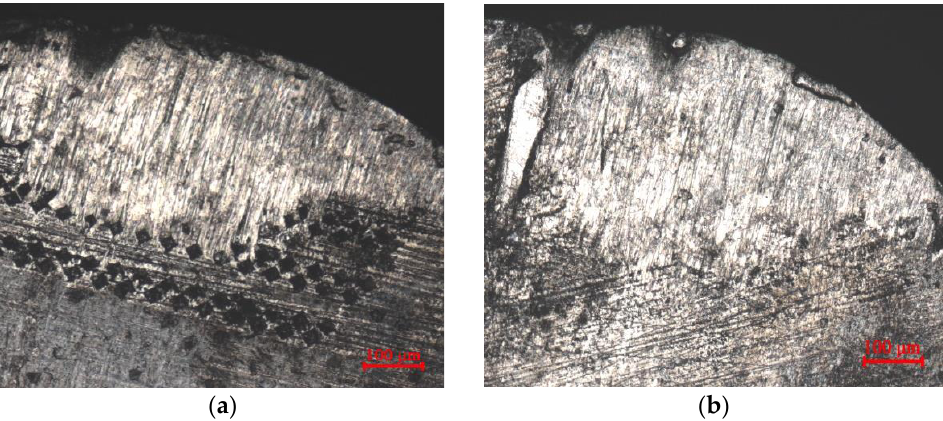
Figure 7. View of the front surface of plates with ( a ) and without ( b ) microtexture with traces of build-up after processing of heat-resistant material at V = 27 m/min, t = 0.5 mm, S = 0.1 mm/rev.